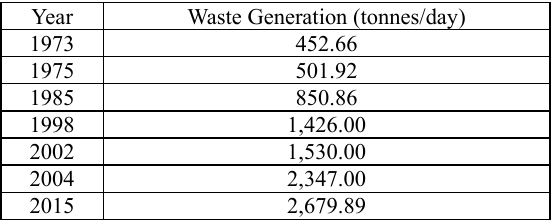
Table 5 . Waste generation and change trends in Nairobi.